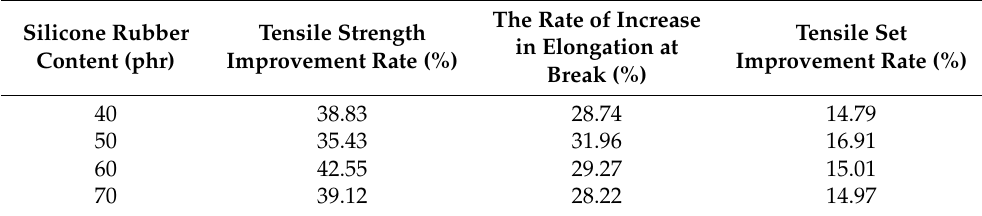
Table 6. The improvement rate of mechanical properties of TPSiV after the addition of silane coupling agent